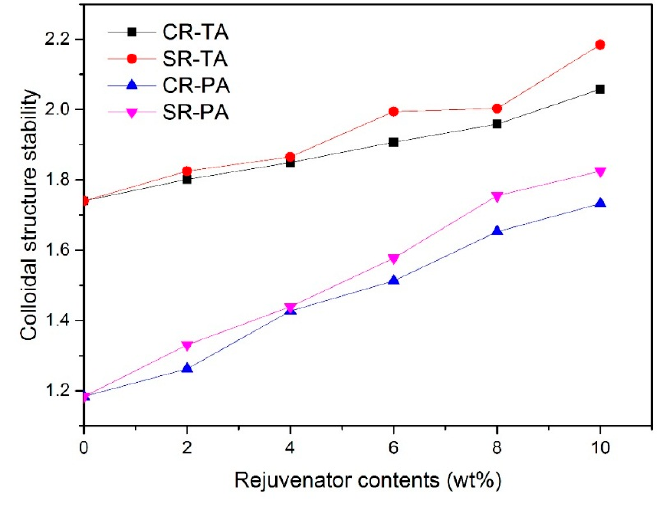
Figure 2. CSI of regenerated bitumen with different rejuvenators.